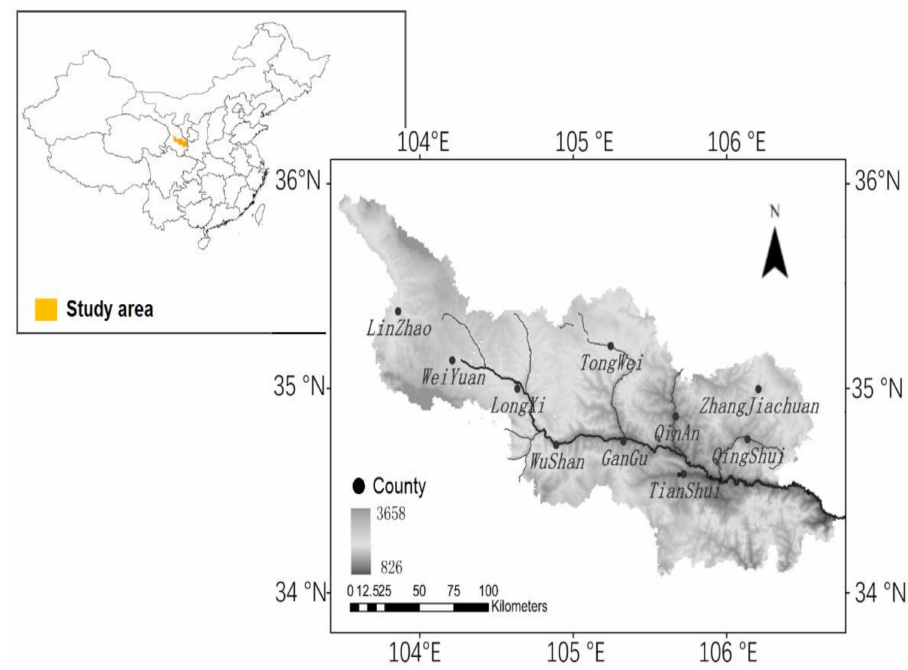
Figure 1. Distribution of the sample in upper reaches of the Weihe River Basin in